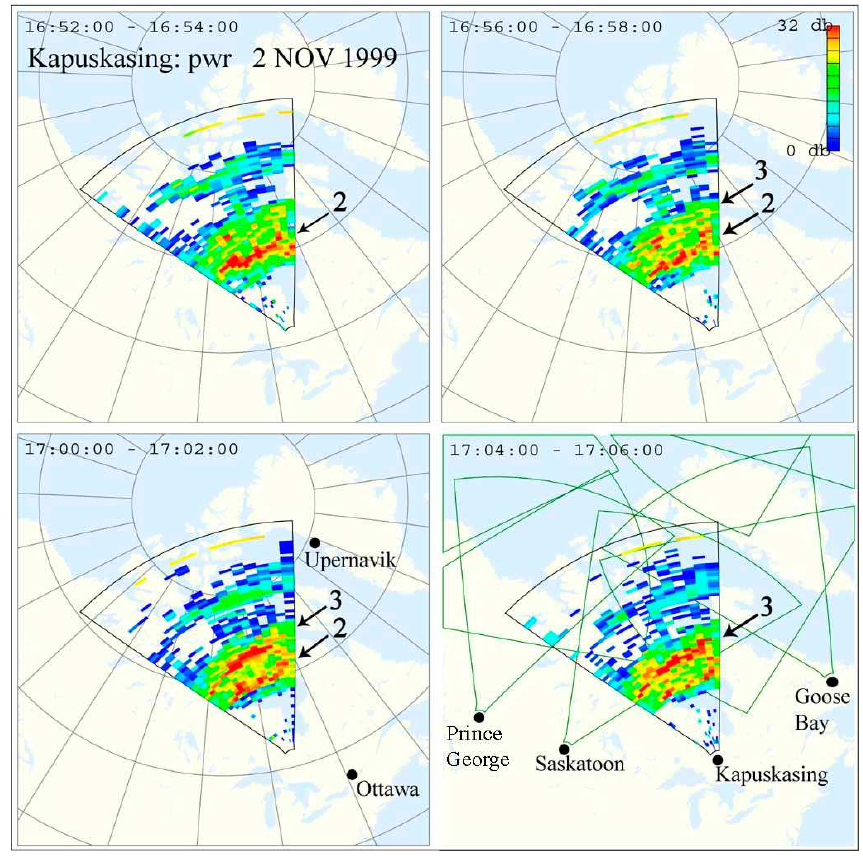
Fig. 3. The ground scatter signatures of a pair of equatorward-moving TIDs (labeled 2 and 3) observed by the Kapuskasing radar. A band